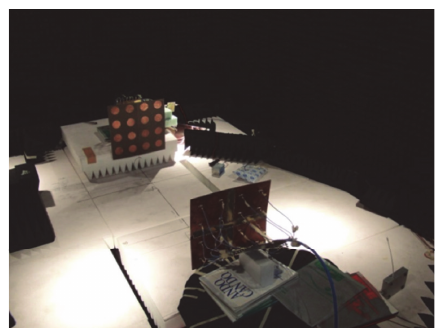
Figure 17: Measurement setup in an anechoic